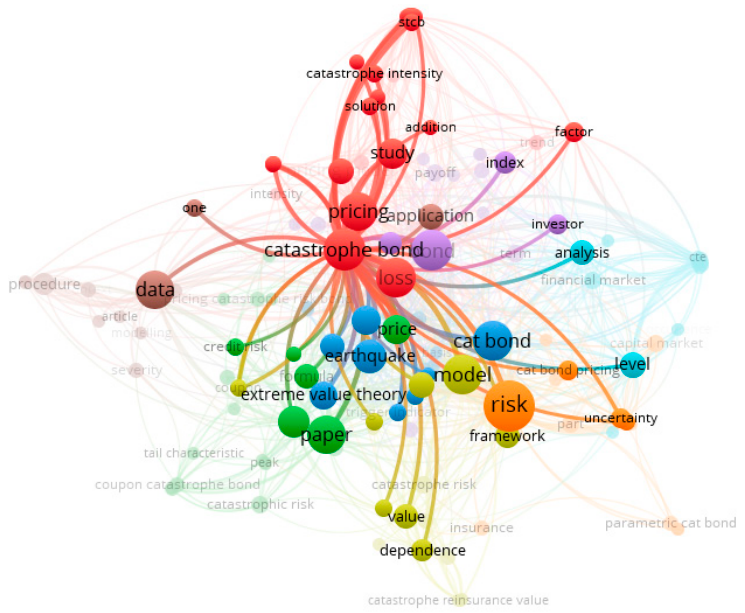
Figure 3. Mapping of earthquake catastrophe bonds with EVT .